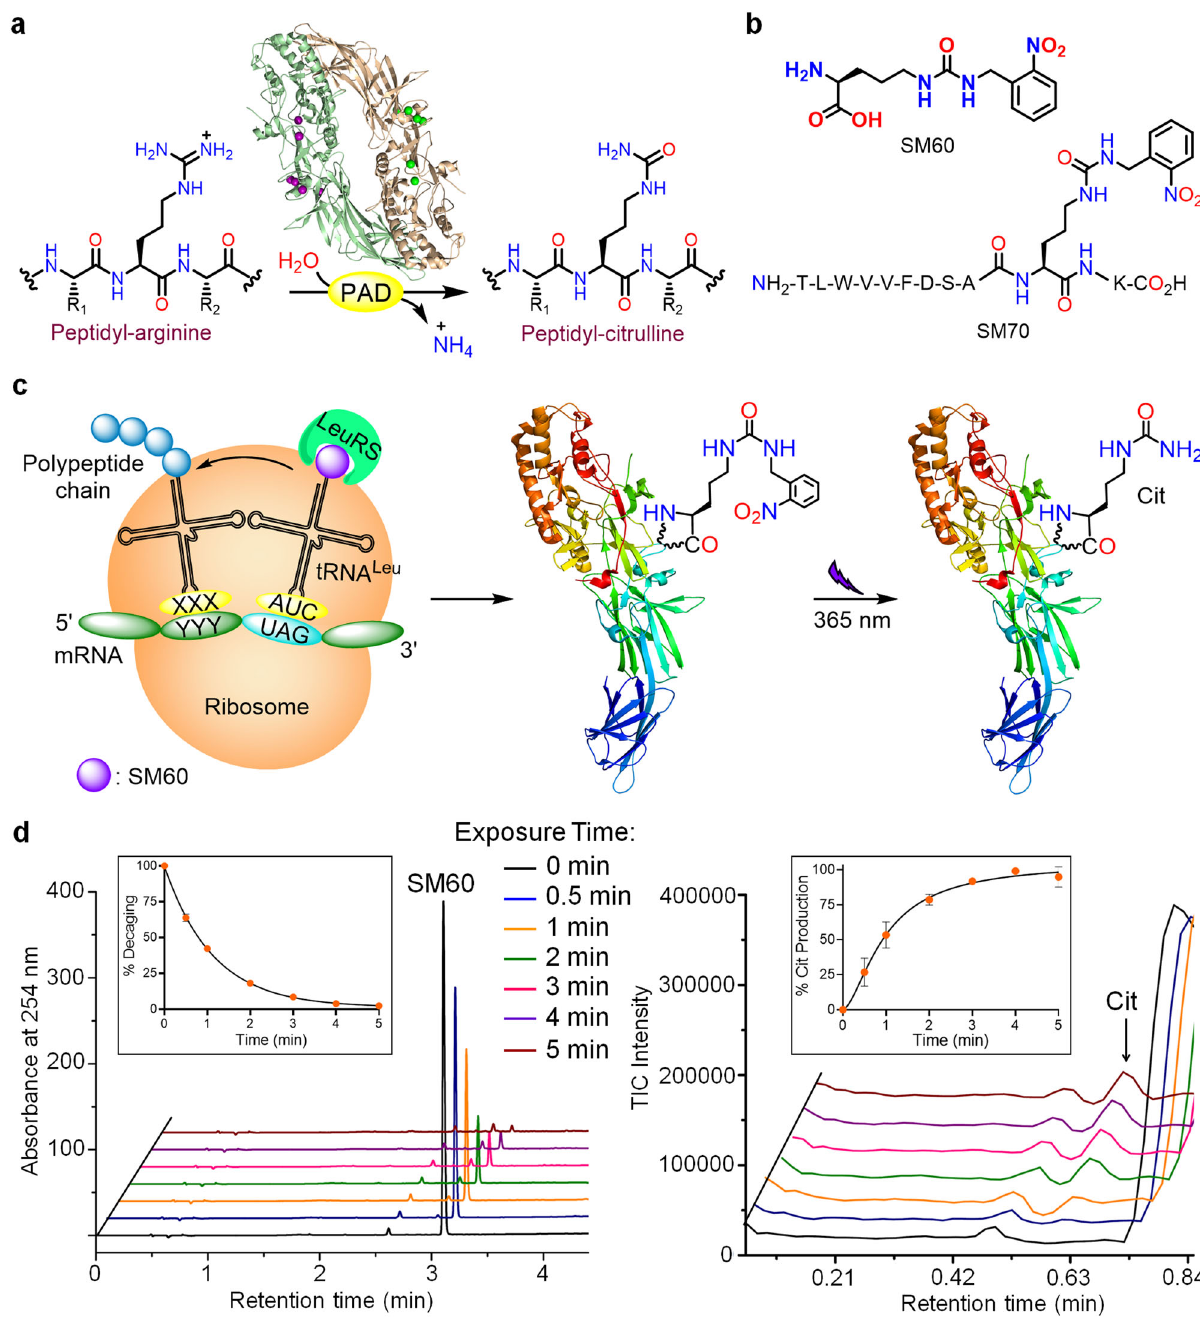
Fig. 1 SM60, a photocaged-citrulline and its conversion to citrulline with 365 nm UV light. a Conversion of peptidyl-arginine to peptidyl-citrulline by the PADs. b Chemical structures of SM60 and SM70. c Schematic representation of the incorporation of SM60 into proteins by an engineered LeuRS-tRNA Leu pair and subsequent conversion to citrulline. d Decaging of SM60 to citrulline with 365 nm UV irradiation. Left and right panels indicate the HPLC and ion chromatograms, showing the disappearance of SM60 and the formation of citrulline (Cit), respectively, with increasing UV exposure. Quantitative analyses of decaging and Cit formation are shown in the insets. n = 2 independent experiments, data are presented as mean value ± SD. Assay mixture: 1 mM SM60, 2 mM DTT, phosphate-buffered saline pH 7.4. Source data are provided as a Source Data fi